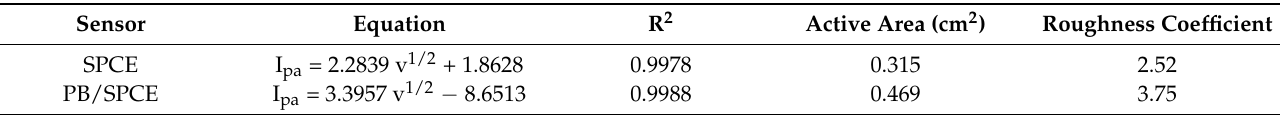
Table 3. The linear fitting equations (I pa vs. v 1/2 ), active areas and roughness coefficients. Sensor Equation R 2 Active Area (cm 2 ) Roughness Coefficient SPCE I pa = 2.2839 v 1/2 + 1.8628 0.9978 0.315 2.52 PB/SPCE I pa = 3.3957 v 1/2 − 8.6513 0.9988 0.469